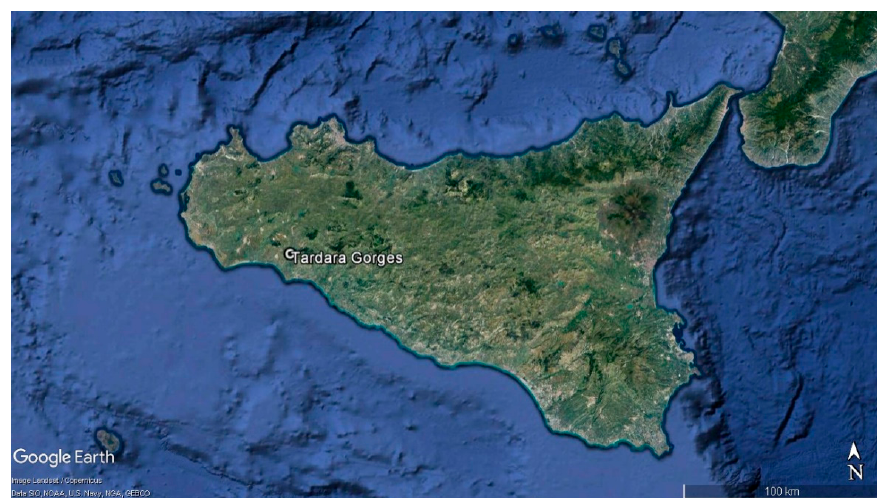
Figure 2. Location of the Tardara Gorges in Sicily.